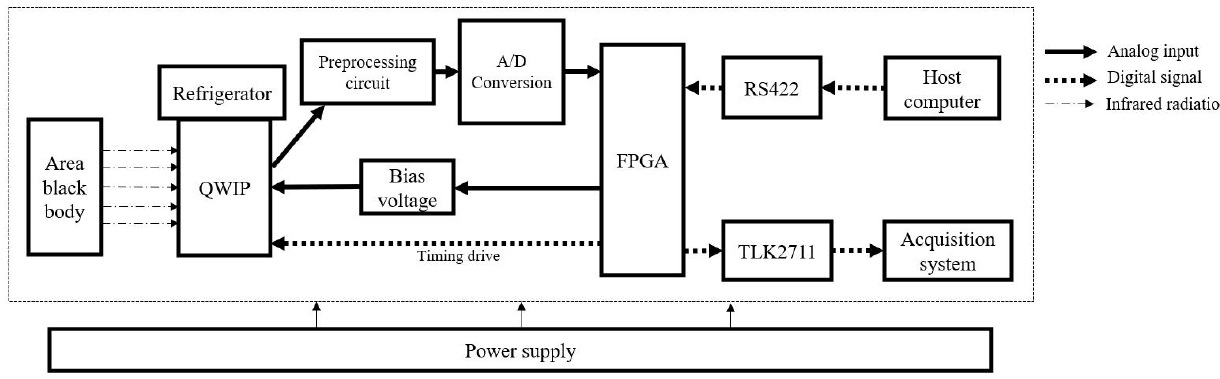
Figure 4. LWIR QWIP detection system.